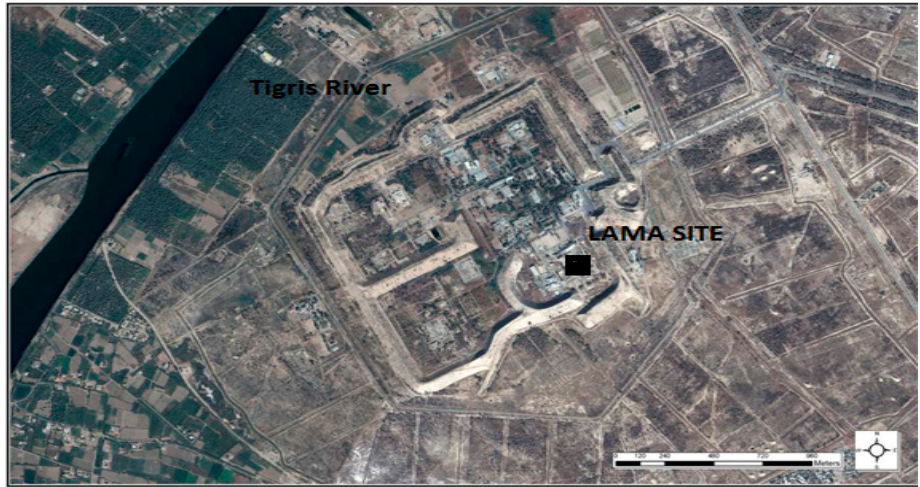
Figure 1. Satellite image for Al-Tuwaitha Nuclear Research Center, Iraq.